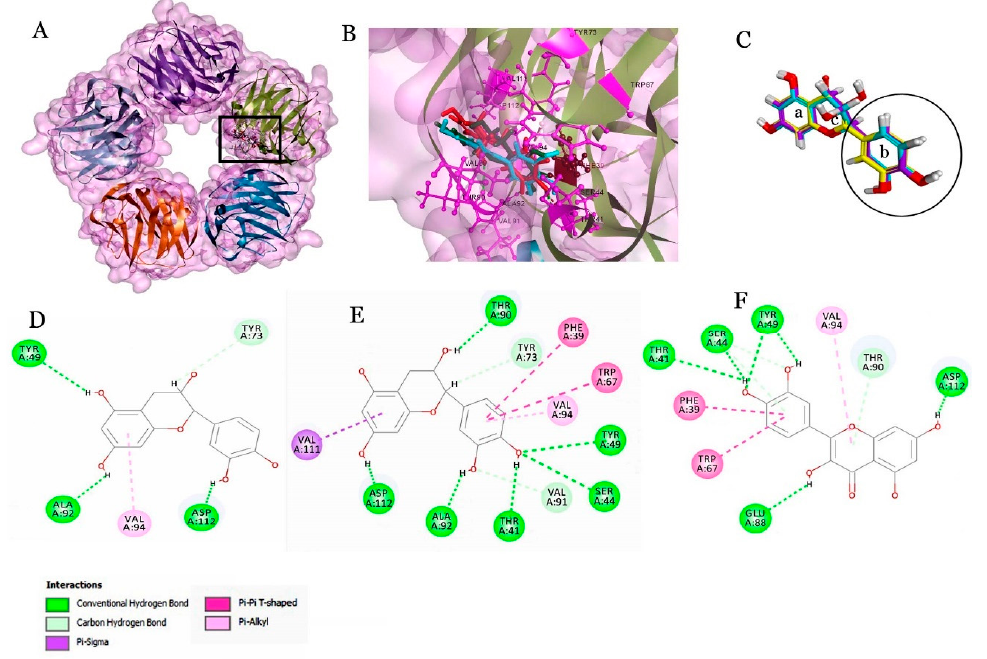
Figure 1. Molecular docking studies with C-reactive protein (CRP). ( A ) Interaction of the ligands into binding pocket (black box) of the pentameric protein; ( B ) expanded view of the binding pocket shows the interacting amino acids (ball and stick model) with the ligands; ( C ) molecular overlay of the flavonoids—catechin, epicatechin and quercetin (a, b) aromatic ring and c is the heterocyclic ring. Circle represents the aromatic ring (b) which has favored the interaction with CRP. ( D – F ) represent the 2D view for interaction of catechin, epicatechin and quercetin with CRP.